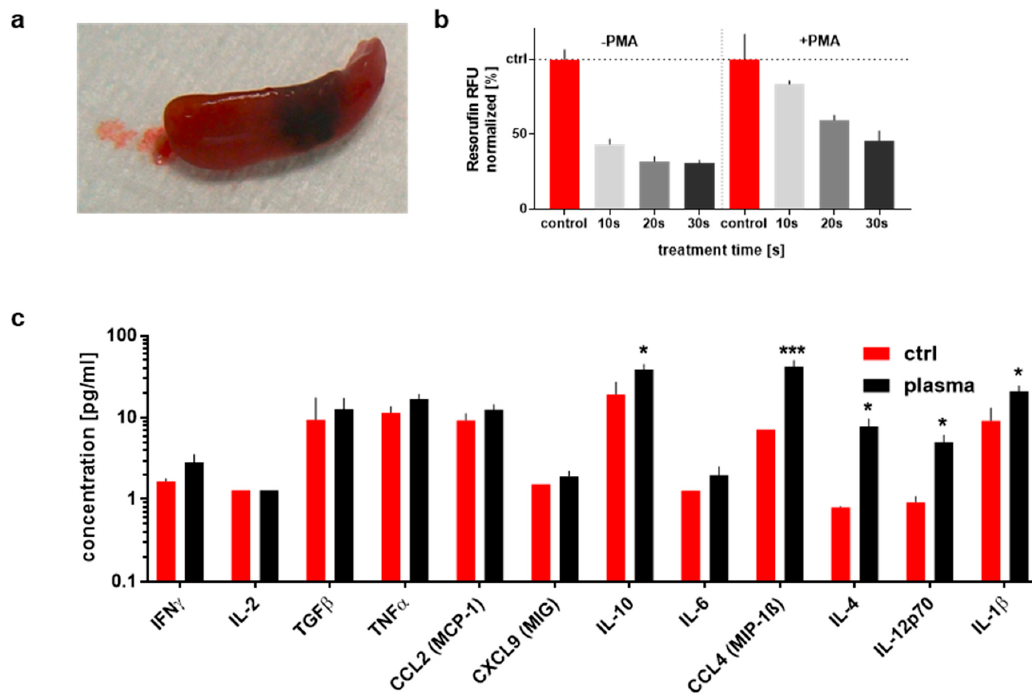
Figure 2. Treatment of murine immune cells with physical plasma. ( a ) Representative murine spleen after harvesting and prior to homogenization; ( b ) metabolic activity of naïve (-PMA) and activated (+PMA) splenocytes after plasma treatment; ( c ) cytokine/chemokine profile 24 h after 120 s plasma treatment in naïve splenocytes. Data are mean +S.E. of several spleens, statistical analysis was performed using t test. PMA: phorbol 12-myristate 13-acetate.